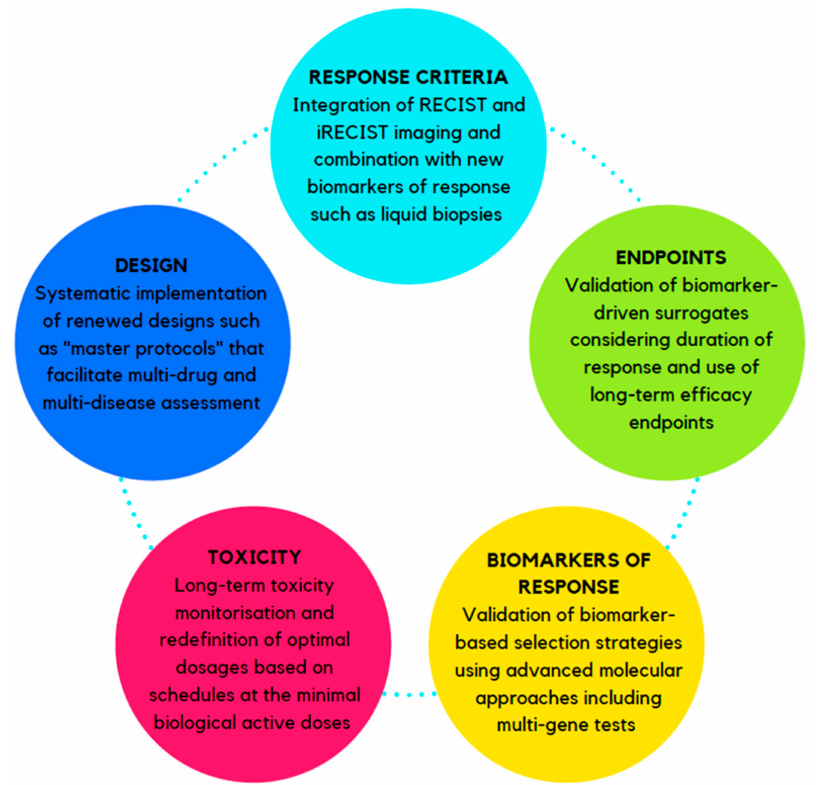
Figure 2. Proposed strategies to optimize the clinical trial design for new immuno-oncology agents. Abbreviations: RECIST: response evaluation criteria in solid tumors, iRECIST: immune response evaluation criteria in solid